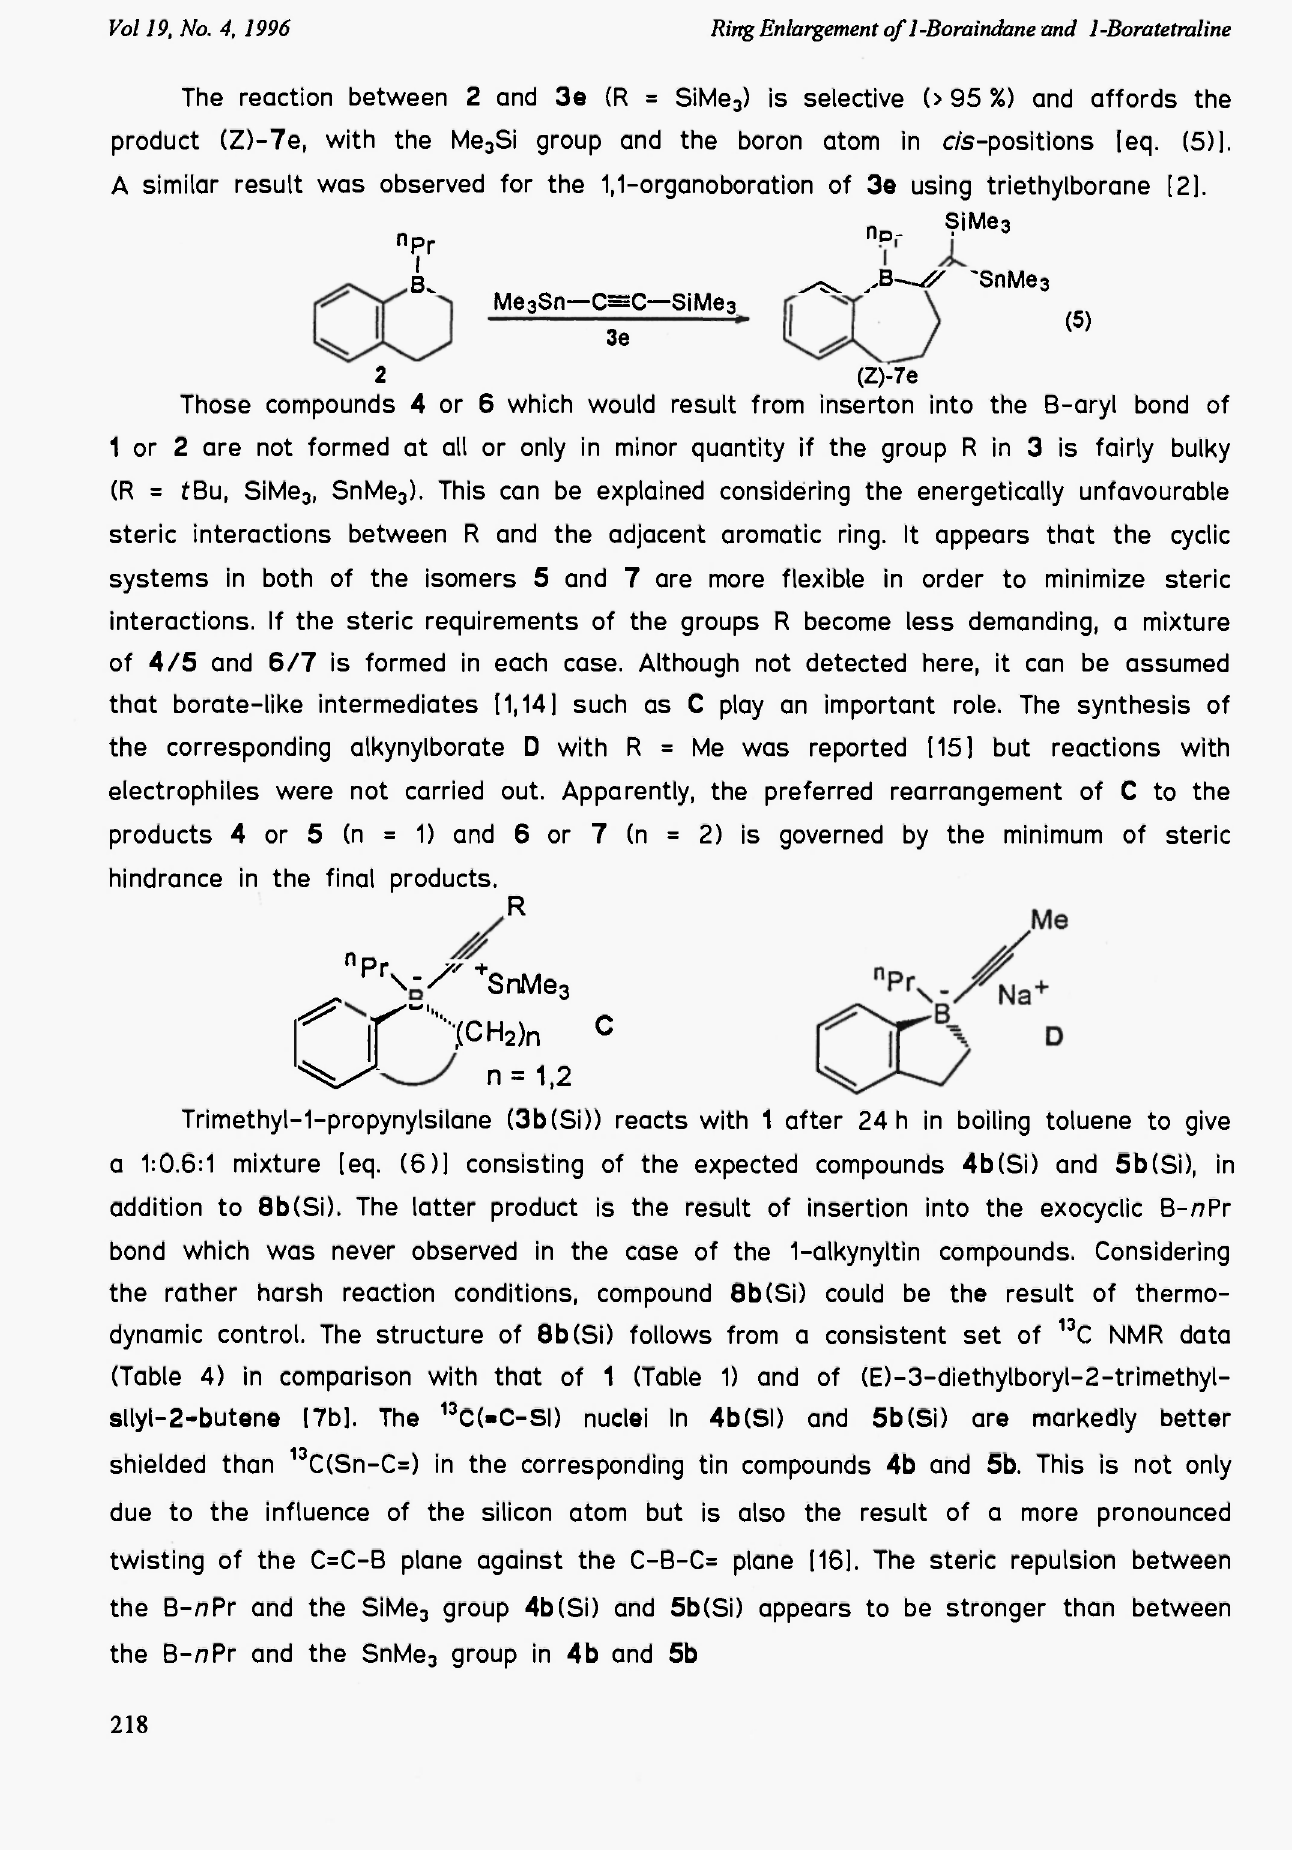
sllyl -2-butene [7b]. The 13 C(»C-SI) nuclei In 4b(SI) and 5b(Si) are markedly